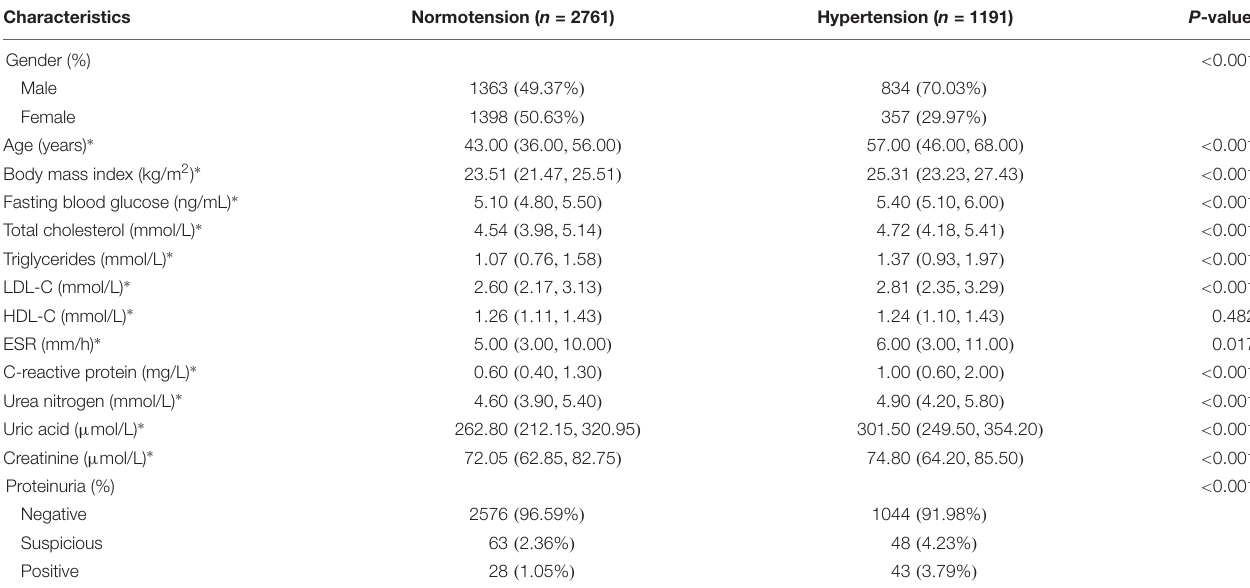
TABLE 1 | Baseline characteristics of all participants ( N =